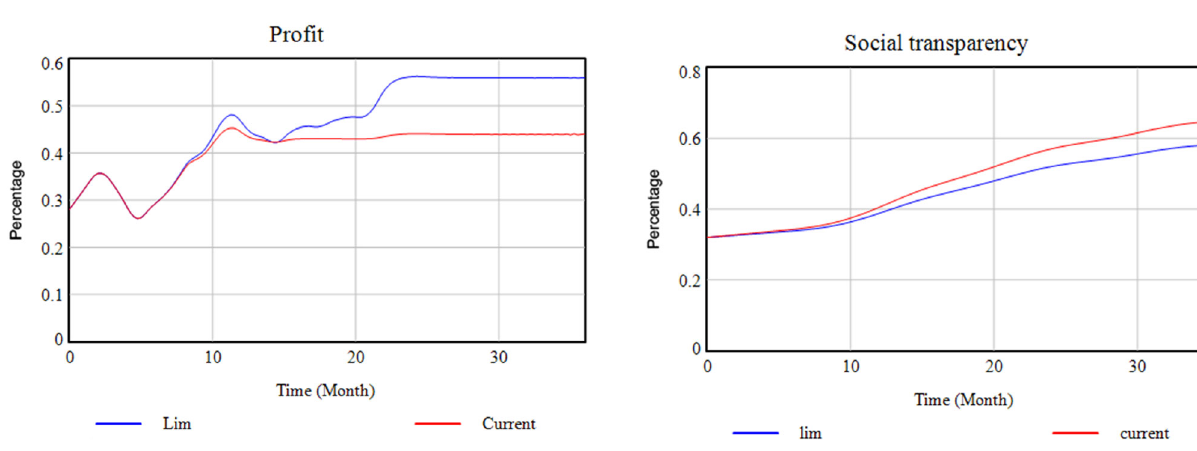
Fig. 10 Model behavior at the average delivery time